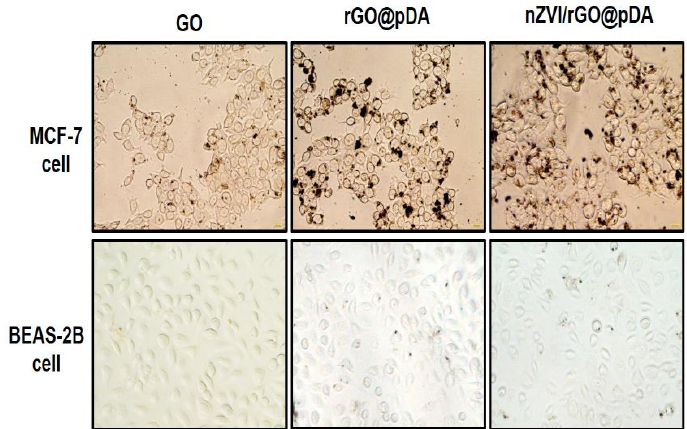
Figure 6. Bar graphs illustrating the biocompatibility and phototherapy effects of nano zero-valent iron immobilized on the surface of reduced graphene oxide then modified with dopamine. Bar graphs are shown illustrating: ( A ) Cell viability of MCF-7 cells after incubation with GO, rGO@pDA, nZVI/rGO@pDA; ( B ) cell viability of BEAS-2B cells incubated with GO, rGO@pDA, and nZVI/rGO@pDA; and ( C ) MCF-7 cell viability following exposure to GO, rGO@pDA, and nZVI/rGO@pDA under near infrared irradiation. Cell viability was measured by thiazolyl blue tetrazolium bromide assay. Key: *** p < 0.001 compared with the control, # p < 0.05 compared with cells exposed to rGO@pDA under near infrared illumination. All experiments were performed three times independently. Abbreviations: GO, graphene oxide; nZVI/GO, reduced graphene oxide modified with dopamine; nZVI/rGO@pDA, nano zero-valent iron immobilized on the surface of reduced graphene oxide then modified with dopamine.